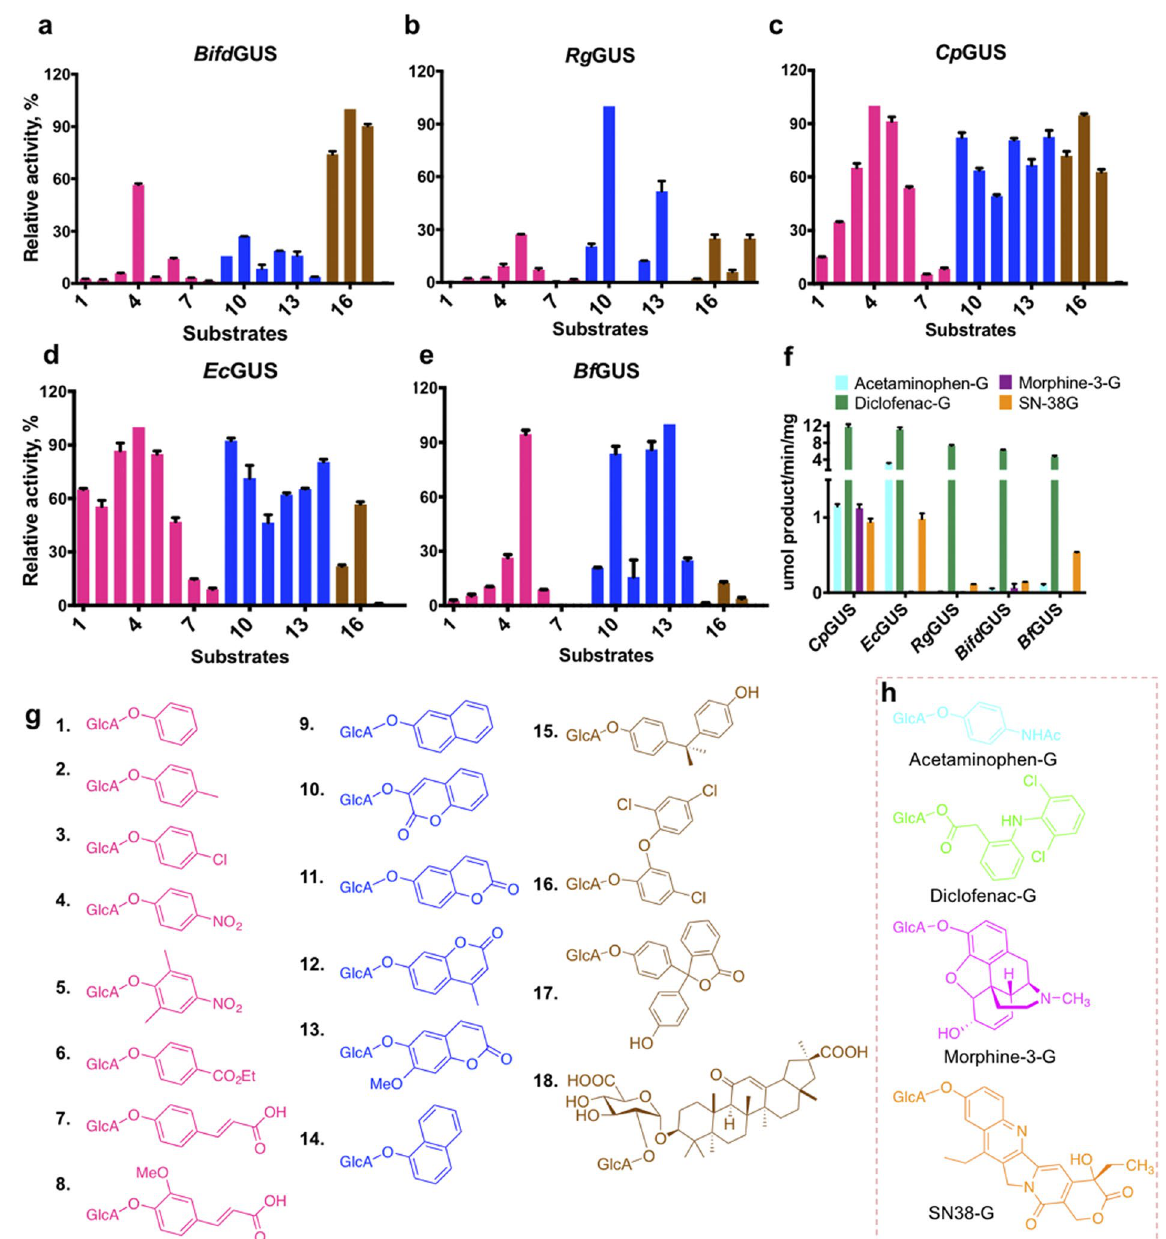
Figure 2. The five tested gut bacterial GUSs have distinct substrate preferences. Substrate preferences of the five gut bacterial GUSs and molecular structures of the glucuronides are shown. Relative activities of ( a ) Bifd GUS, ( b ) Rg GUS, ( c ) Cp GUS, ( d ) Ec GUS, and ( e ) Bf GUS toward substrates 1 – 18 . The structures of the substrates are shown in ( g ) and were categorized into three groups according to the type of aglycone as mono- aromatic (pink), fused aromatic (blue), and bulky aglycones (brown). Panel f compares the specific activities of the GUSs for five drug glucuronides with their structures are shown in panel h . Relative activities of the GUSs were calculated as specific activity ( μ mol/min/mg) and were determined as follows. Enzymes (10 ng of Cp GUS and Ec GUS, and 50 ng of Rg GUS, Bf GUS, and Bifd GUS) were incubated with 250 μ M substrates in 50 mM sodium citrate, 150 mM NaCl at pH 6.0. The highest activities for a given substrate was set as 100%. For Cp GUS, Ec GUS, Rg GUS, Bf GUS, and Bifd GUS, the greatest activities were for 4 , 10 , 15 , and 16 , respectively. ( g ) Molecular structures of xenobiotic glucuronides used in this study are for: 1 , phenoxy; 2 , p -methylphenoxy; 3 , p -chlorophenoxy; 4 , p -nitrophenoxy; 5 , 2,6-dimethyl-4-nitrophenoxy; 6 , 4-(ethoxycarbonyl)phenoxy; 7 , 4-(( E )-2-carboxyvinyl)phenoxy; 8 , 4-(( E )-2-carboxyvinyl)-2-methoxyphenoxy; 9 , naphthalen-2-yloxy; 10 , 2-oxo-2 H -chromen-3-yloxy; 11 , 2-oxo-2 H -chromen-6-yloxy; 12 , 4-methylumbelliferyloxy; 13 , 7-methoxy-2- oxo-2 H -chromen-6-yloxy; 14 , naphthalen-1-yloxy, 15 , bisphenyl-A; 16 , triclosan; 17 , phenolphthalein; and 18 , glycyrrhizin. ( h ) Molecular structures of drug